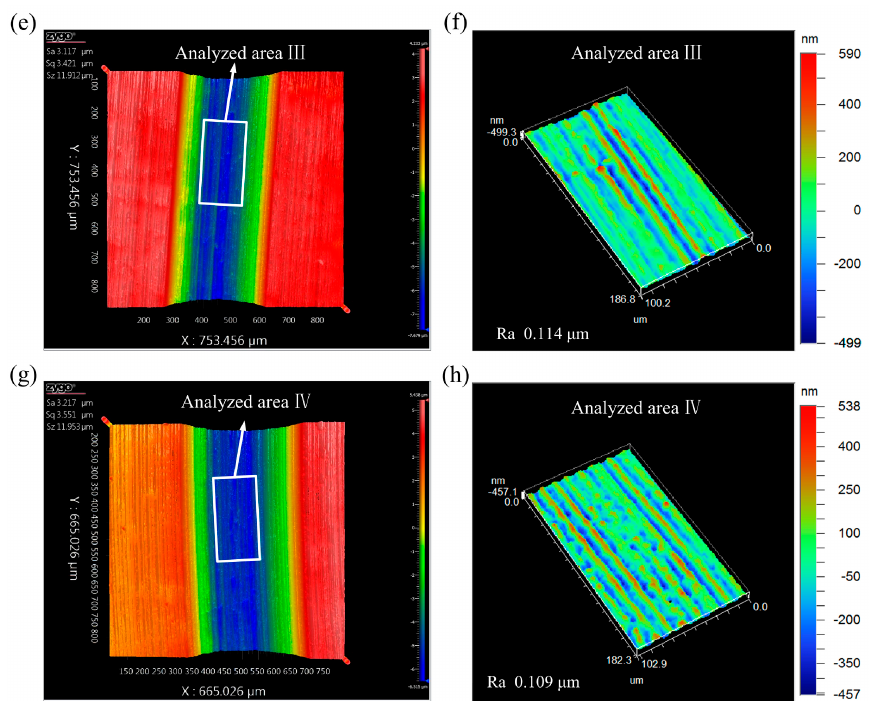
Figure 8. The views of machined micro-grooves (the predetermined depth of cut was 8 μ m): ( a ) surface topography of machined micro-groove during CC; ( b ) surface roughness of analyzed area I; ( c ) surface topography of machined micro-groove during UEVC (TSR = 1/12); ( d ) surface roughness of analyzed area II; ( e ) surface topography of machined micro-groove during UEVC (TSR = 1/24); ( f ) surface roughness of analyzed area III; ( g ) surface topography of machined micro-groove during UEVC (TSR = 1/48); ( h ) surface roughness of analyzed area IV.